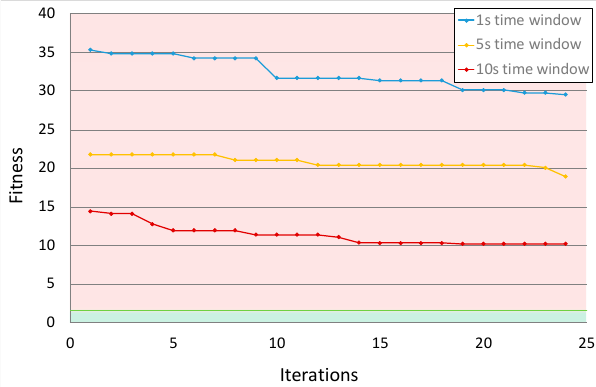
Figure 9. Evolution of the mean value of the fitness of the best solution found by the GA for the case of two intermediate timing points.